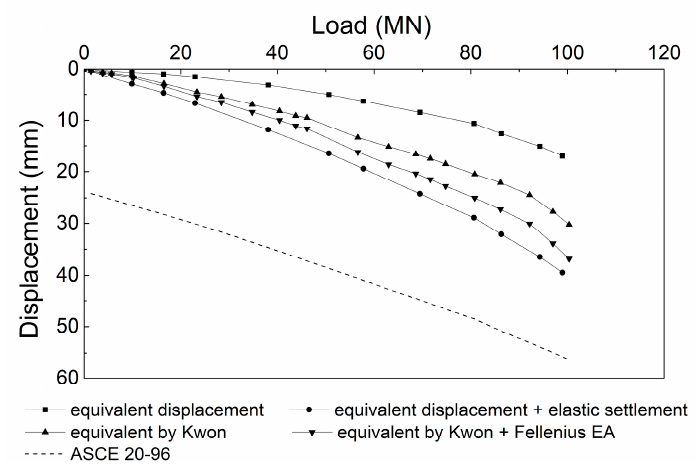
Figure 7. Equivalent load-displacement curve of TP